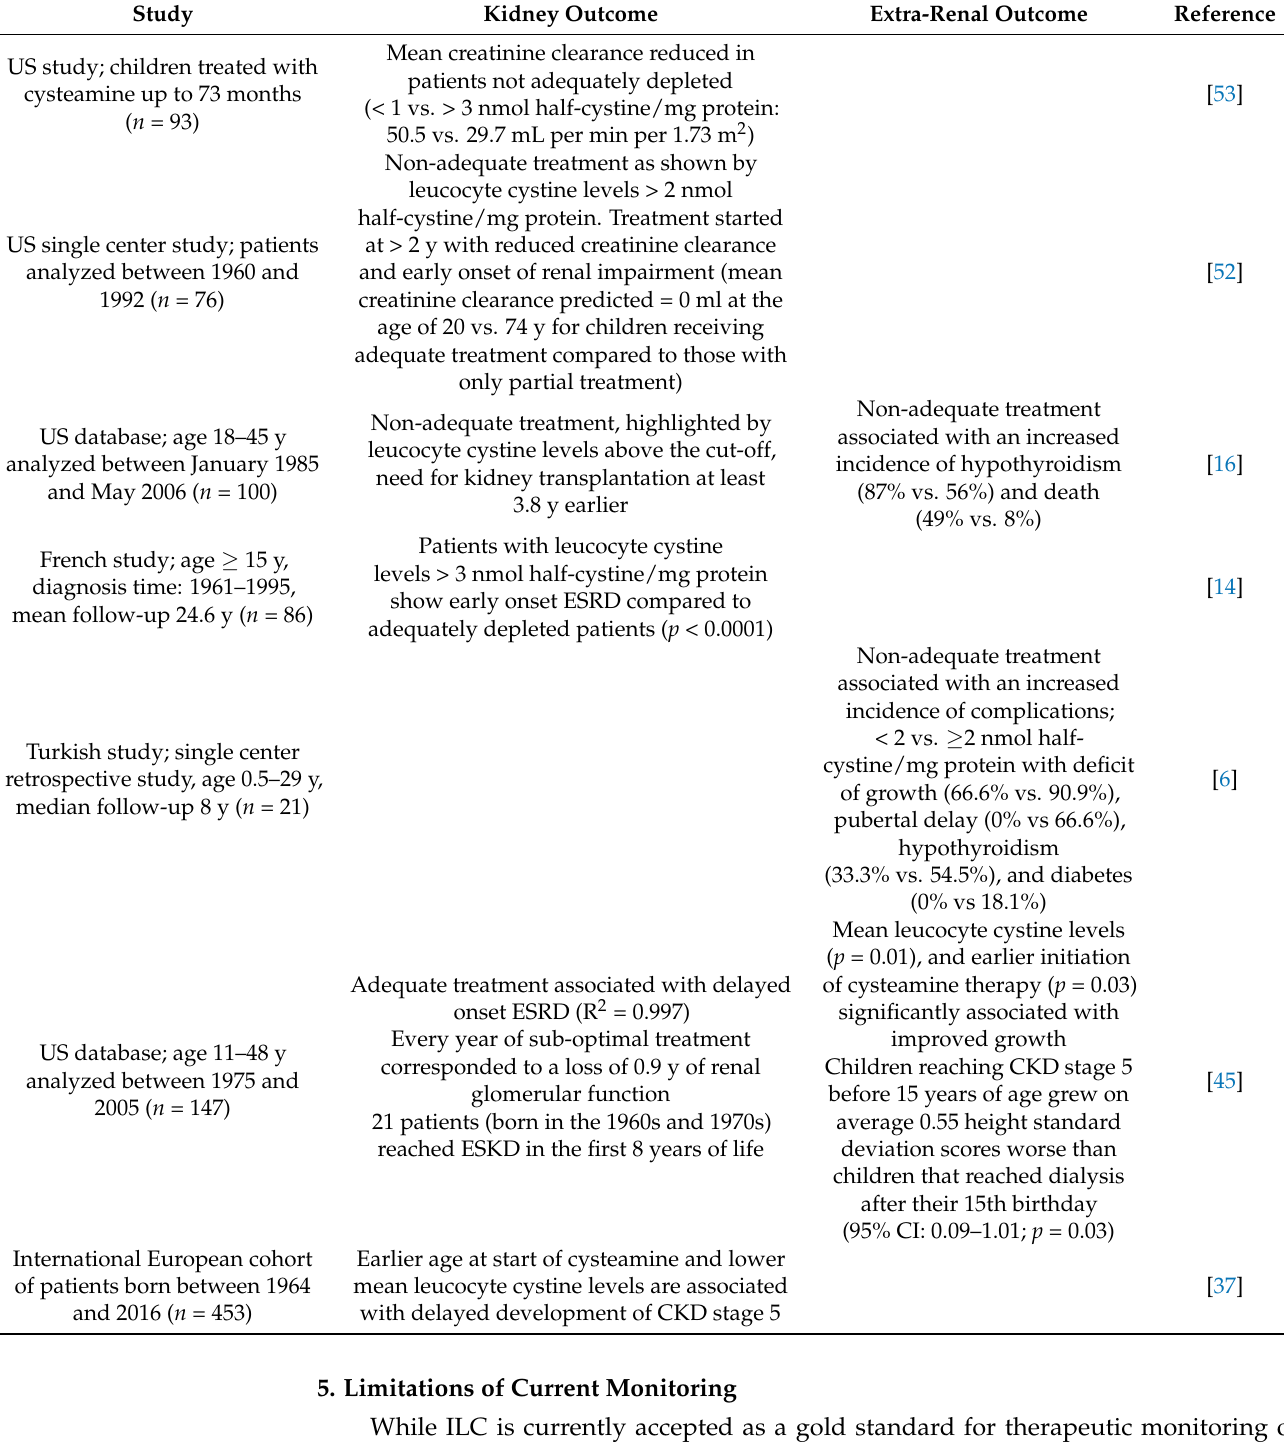
Table 1. Clinical consequences of inadequate cystine depletion